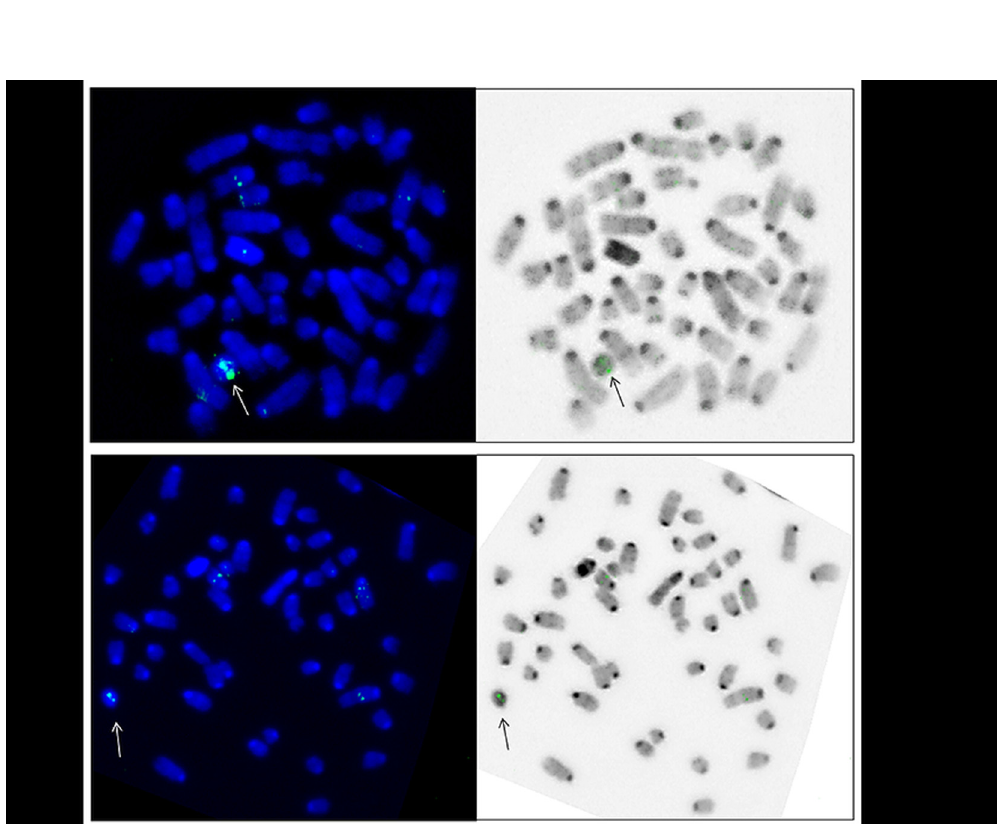
Fig 6. Hybridization of B-marker probe in two metaphases in 1B A . flavicollis . B chromosome is marked with an